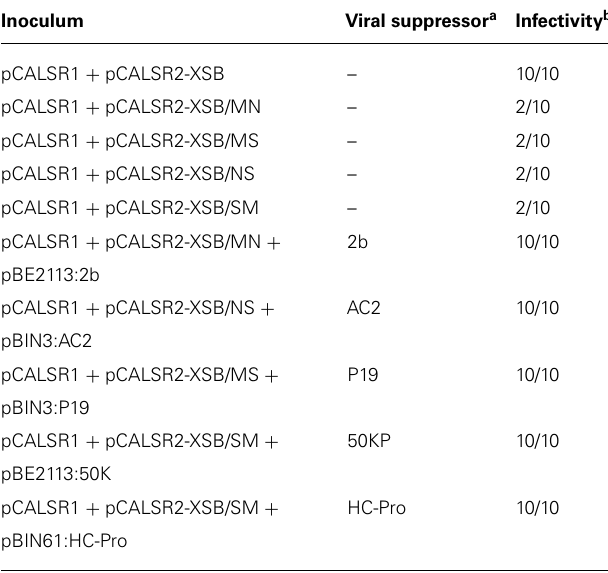
a RNA silencing suppressors expressed from co-infiltrated plasmid DNAs. The symbols2b,AC2, P19, 50KP,andHC-ProaresuppressorproteinsofCMV,ToMHV, TBSV, ACLSV, and PVY, respectively. b Number of infected plants/inoculated plants based on the detection of viral RNA by RT-PCR. Sum of two independent experiments.